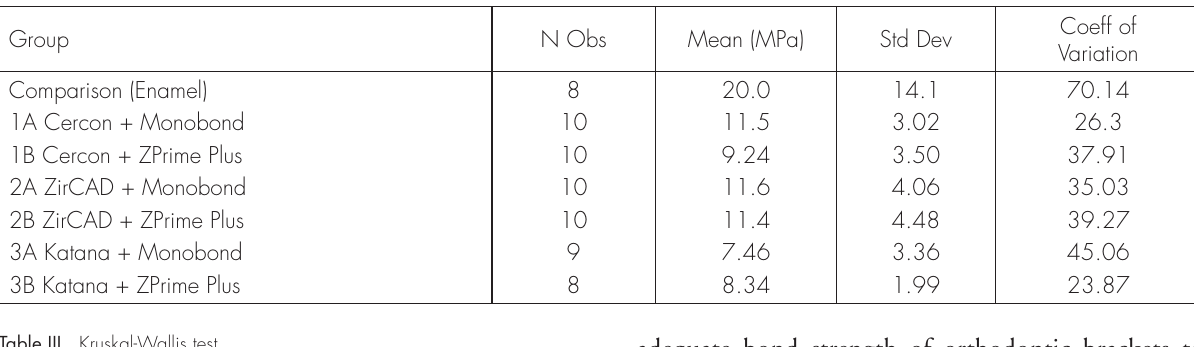
Table III. Kruskal-Wallis Chi-Square